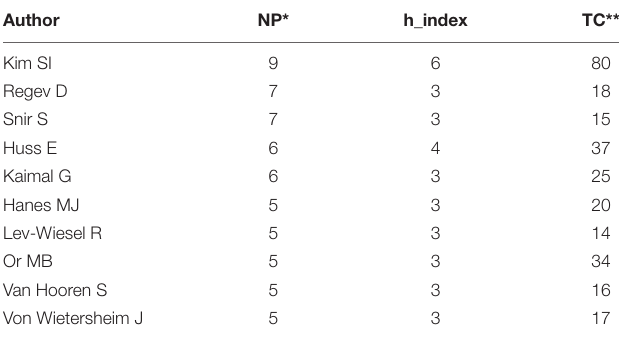
TABLE 4 | Authors and frequency of publications on art